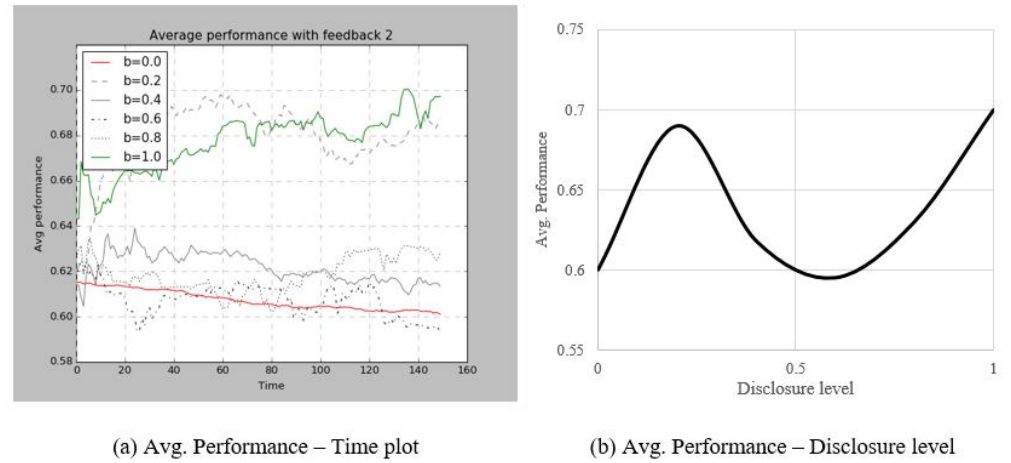
Figure A2. Average performance result of ‘positive feedback to high-performed group’ condition model.